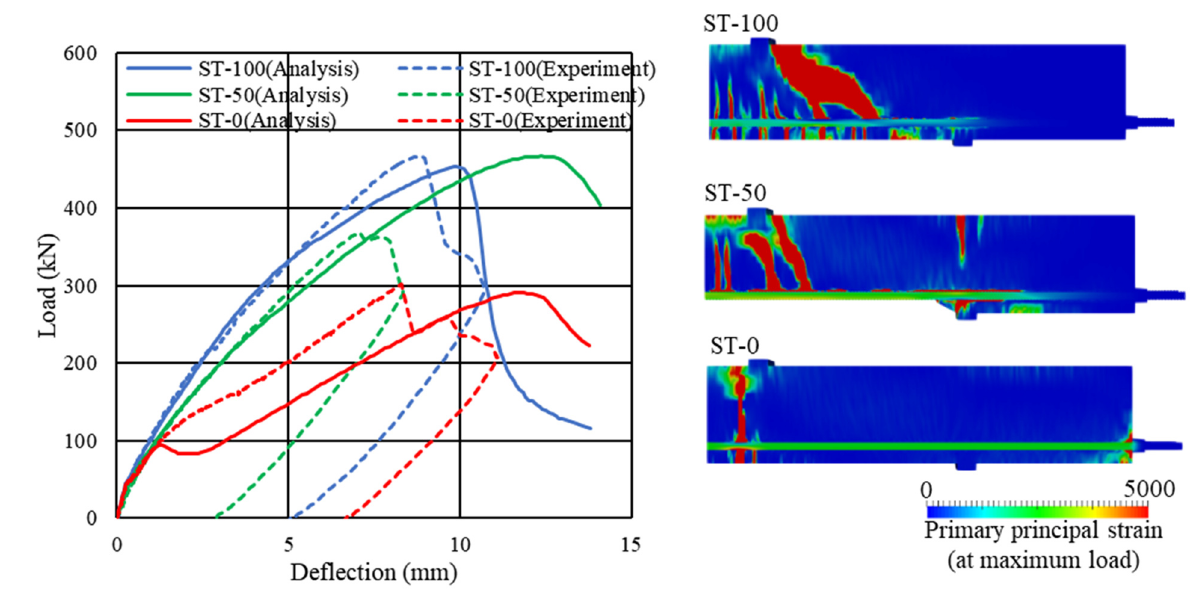
Figure 12. Reproduction FE analysis results.